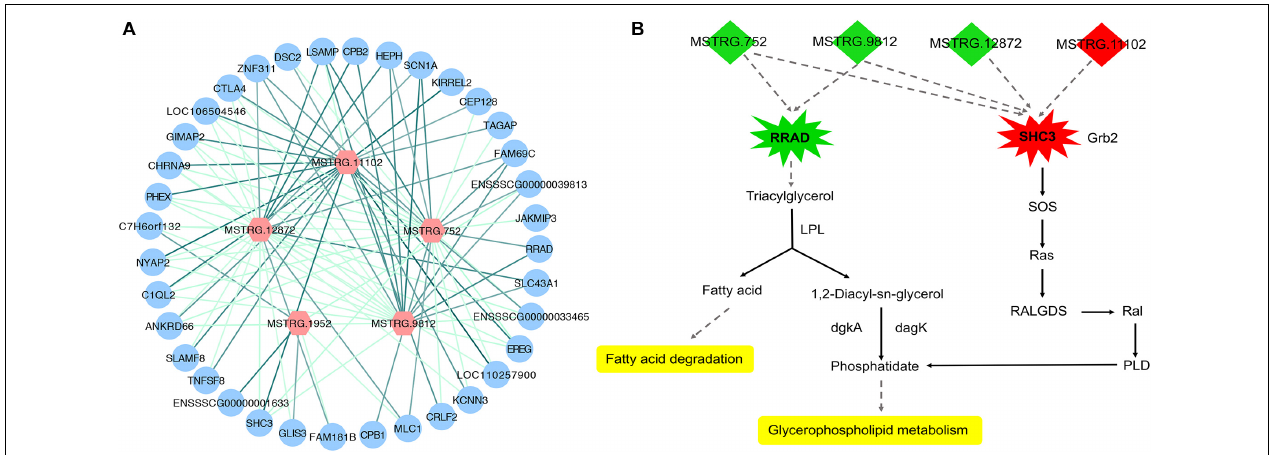
FIGURE 6 | Expression regulation analysis of DEL genes and their DEPTGs. (A) Co-expression network of DELs and DEPTGs.DELs are indicated in red hexagons;DEPTGs are indicated in blue circles; light green edge represent DELs downregulate DEPTGs; dark green edge represent DELs upregulate DEPTGs. (B) Potential pathways for DELs and DEPTGs. red indicates that the genes are upregulated in fat pigs, green indicates downregulation in fat pigs, and yellow indicates potential pathways for DELs and DEPTGs; quadrilaterals represent DELs, irregular polygons represent DEPTGs, and dash lines indicate predict interactions.